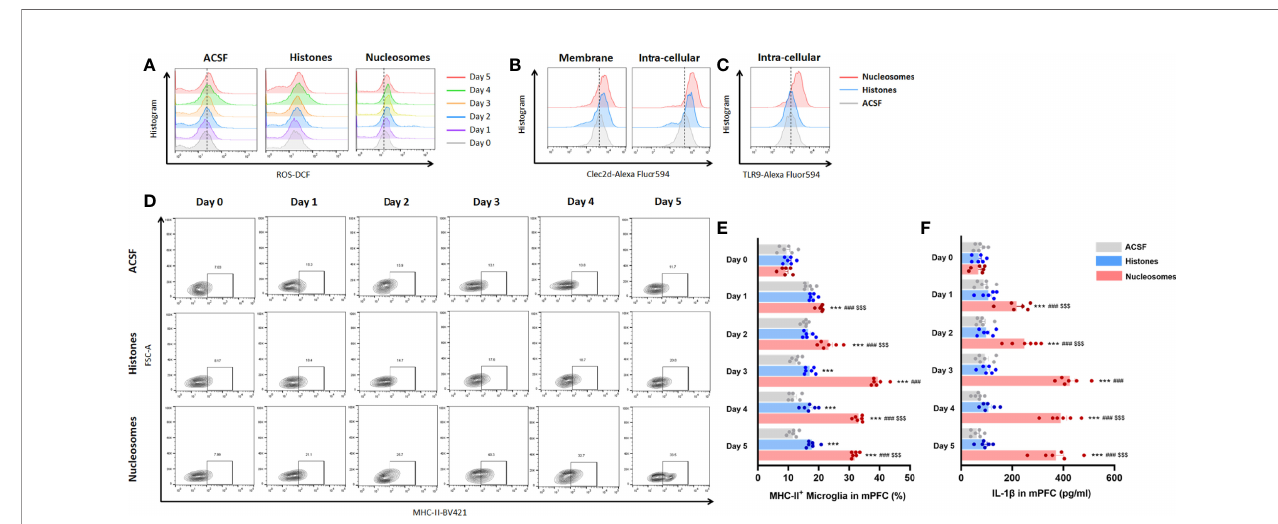
FIGURE 6 | Extracellular nucleosomes accelerated microglial oxidative stress and pro-in fl ammatory activation but not histones in mPFC. (A) Representative histogram images showing CD11b + CD45 Low microglial ROS before and 1~5 days after ACSF, histones, and nucleosomes stereotactic injection in mPFC were presented. (B) Representative histogram images showing CD11b + CD45 Low microglial Clec2d on the membrane and intracellular on day 3 after ACSF, histones, and nucleosomes stereotactic injection in mPFC were presented. (C) Representative histogram images showing intracellular TLR9 on day 3 after ACSF, histones, and nucleosomes stereotactic injection in mPFC were presented. (D) Representative fl ow cytometry images showing the percentage of CD11b + CD45 Low MHC-II + microglia before and 1~5 days after ACSF, histones, and nucleosomes stereotactic injection in mPFC were presented. (E) Percentage of CD11b + CD45 Low MHC-II + microglia before and 1~5 days after ACSF, histones, and nucleosomes stereotactic injection in mPFC was analyzed (repeated measurement ANOVA with Tukey ’ s post hoc test post hoc , *** P < 0.001, compared with CONT; ### P < 0.001, compared with Histones; $$$ P < 0.001, compared with nucleosomes day 0; n = 6). (F) Concentration of IL-1 b before and 1~5 days after ACSF, histones, and nucleosomes stereotactic injection in mPFC was analyzed (repeated measurement ANOVA with Tukey ’ s post hoc test post hoc , *** P < 0.001, compared with CONT; ### P < 0.001, compared with histones; $$$ P < 0.001, compared with nucleosomes day 0; n =